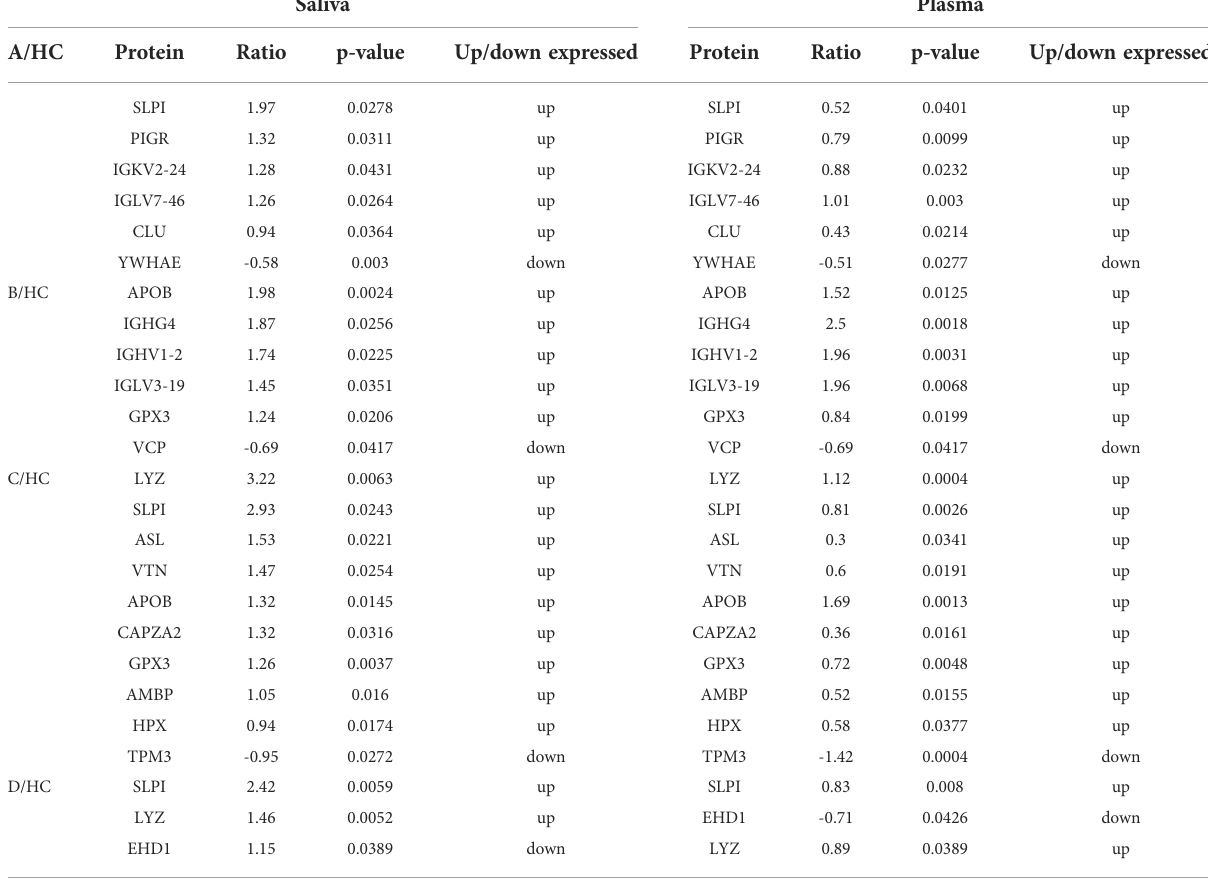
TABLE 7 Common up and down DEPs in saliva and plasma between IgG4-RD patients of four distinctive phenotypes and HC samples with same expression tendencies.